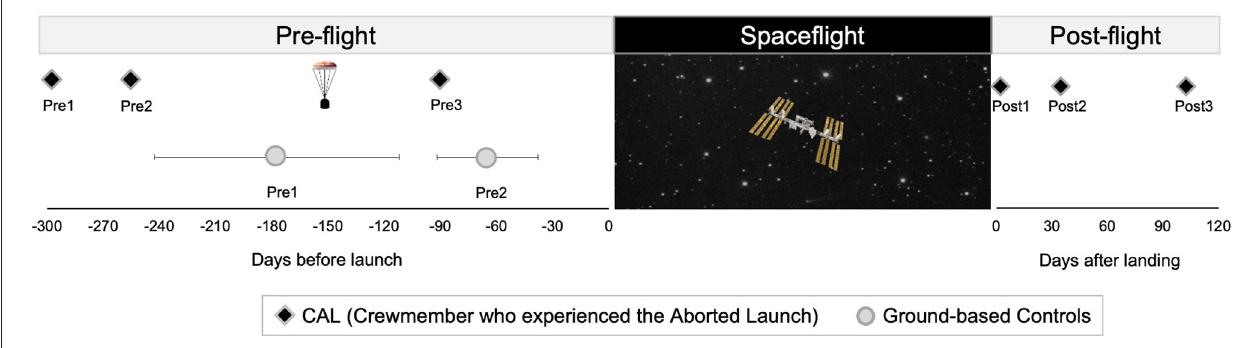
FIGURE 1 | Testing Timelines. Left: timing of pre-flight MRI scans for CAL (black diamonds) and controls (circles). The capsule icon indicates the timing of the aborted launch. Control group data are presented as means, with error bars indicating SD. Right: timing of CAL’s post-flight scans. CAL, Crewmember who experienced the Aborted